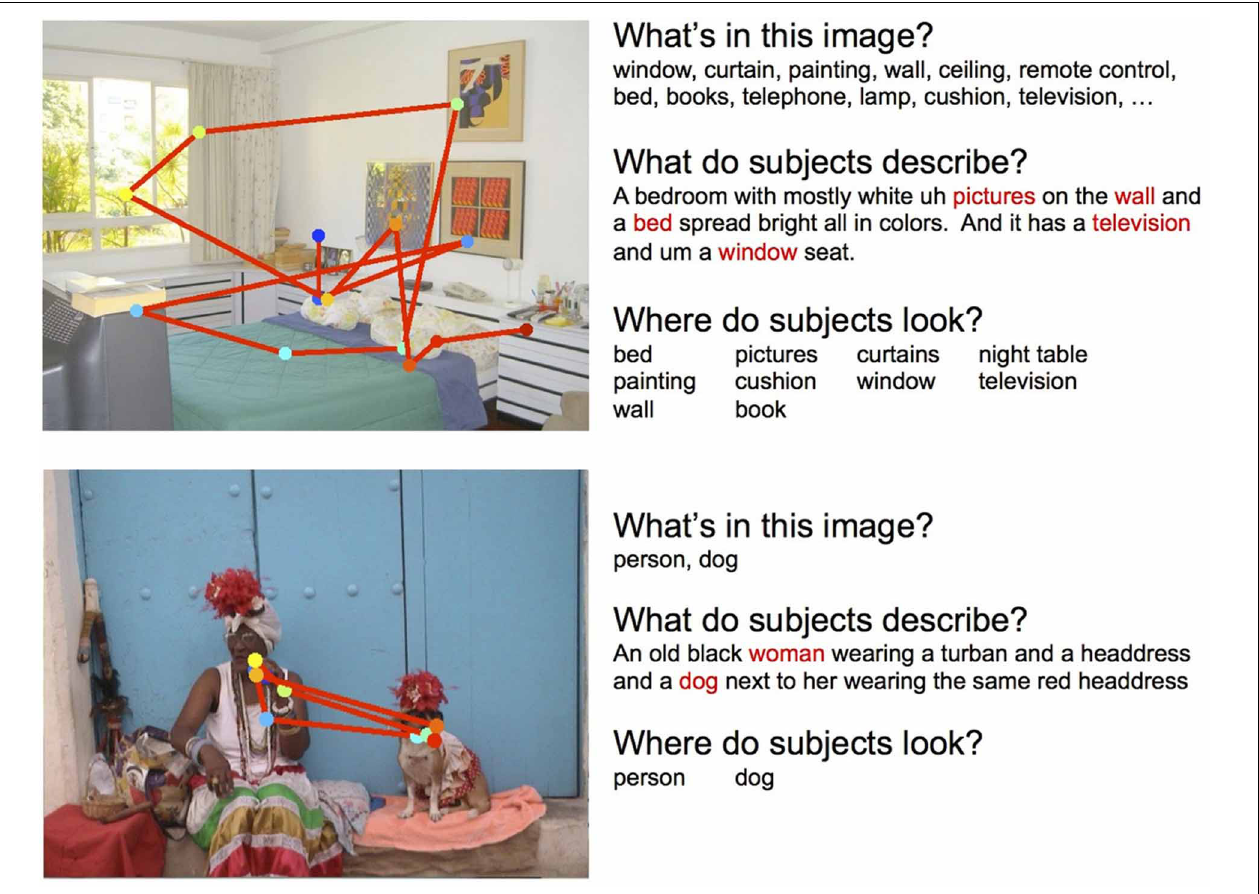
FIGURE 3 | Examples of scanpaths and descriptions for the SUN09 (top) and Pascal (bottom) experiments. Left: Gaze patterns where each dot indicates a fixation. Colors indicate earlier (blue) to later (red) fixations.